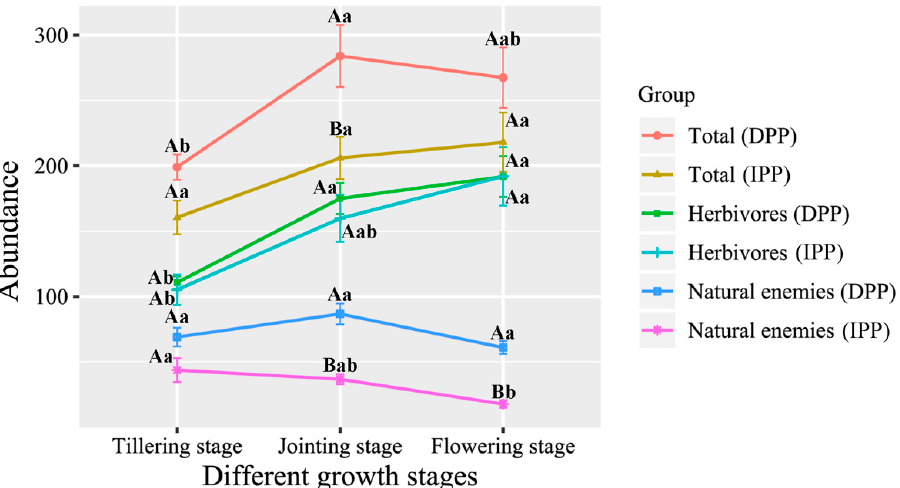
Figure 5. Abundance of different functional groups at different growth stages and under different planting patterns. The error bars indicate the standard errors (SE) of the means. Values followed by different capital letters are significantly different between different planting patterns ( p < 0.05). Values followed by different lowercase letters are significantly different among growth stages ( p < 0.05).